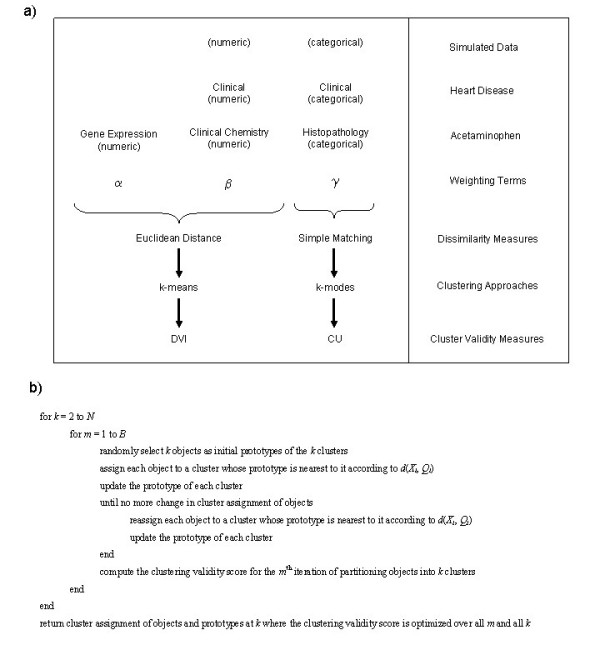
Modified k-prototypes clustering of mixed data types. a) The data sets used for clustering and the components of the modk-prototypes algorithm. The type of the data is denoted in parentheses. b) The k-prototypes algorithm was modified (termed modk-prototypes) to include B iterations of the assignment of the samples to the k number of clusters for each k = 2 to N number of samples. d(Xi, Ql) is the dissimilarity function between the ith sample and the lth cluster prototype. The cluster prototypes are updated and the samples are reassigned repeatedly until there is no more change in cluster assignment. The validity score is computed for the final assignment of the samples. The number of clusters in the data is estimated by finding the assignment of the samples (over all B initializations and all k partitions) that yielded the optimal validity score.